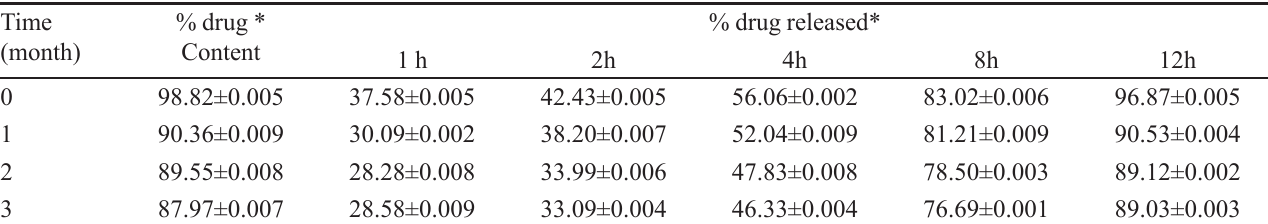
TABLE V - Stability of extended release F4 (capsule containing 8% Explotab®) under accelerating